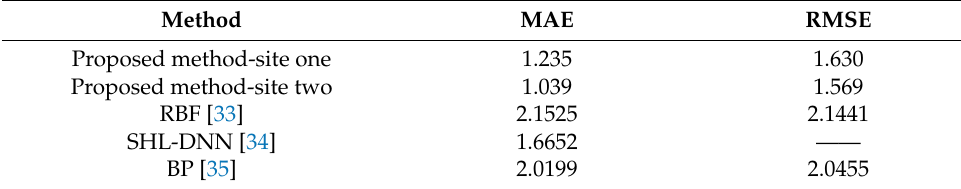
Table 4. Contrast between different